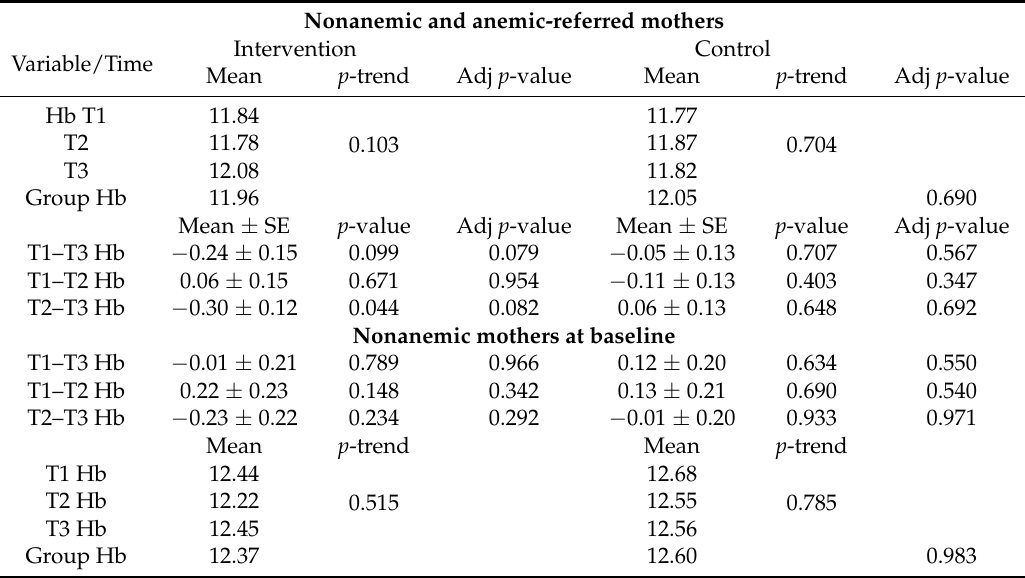
Table 5. Hemoglobin levels of child-bearing age women and the effects of Hibiscus sabdariffa meal consumption on indicators across study